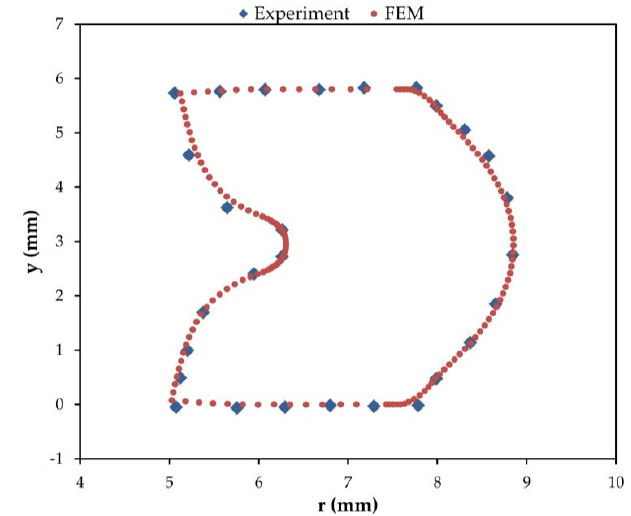
Figure 6. Comparison between the part shape and FEM results obtained by multi-parameter optimization.